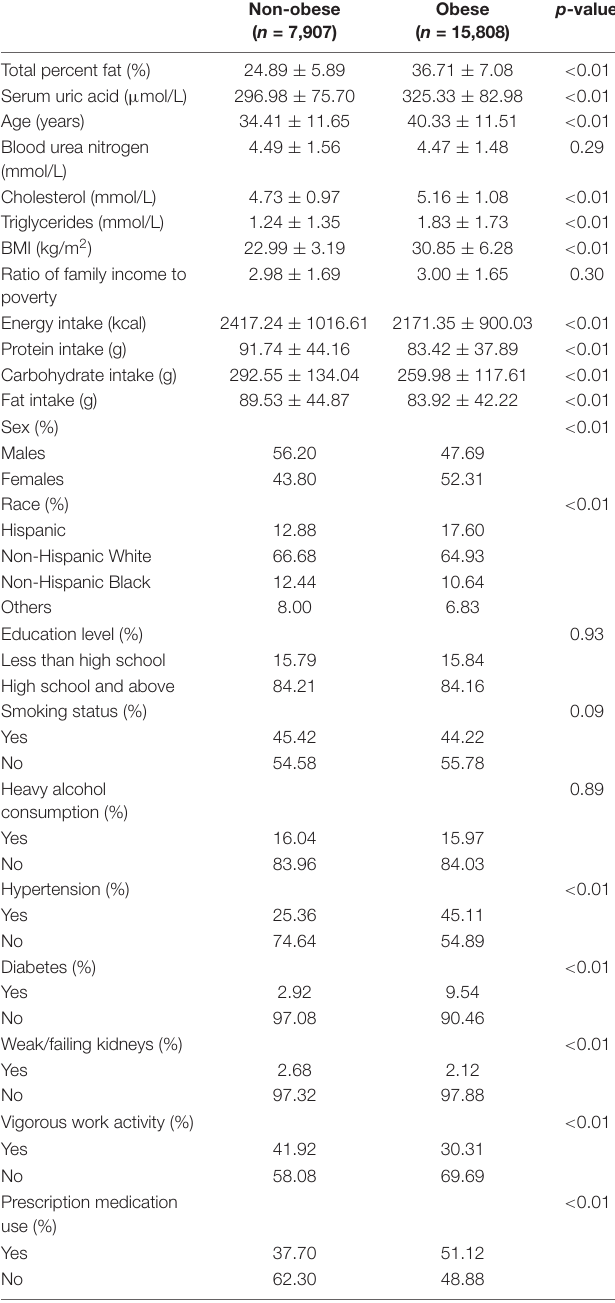
TABLE 1 | Weighted characteristics of study samples based on obesity